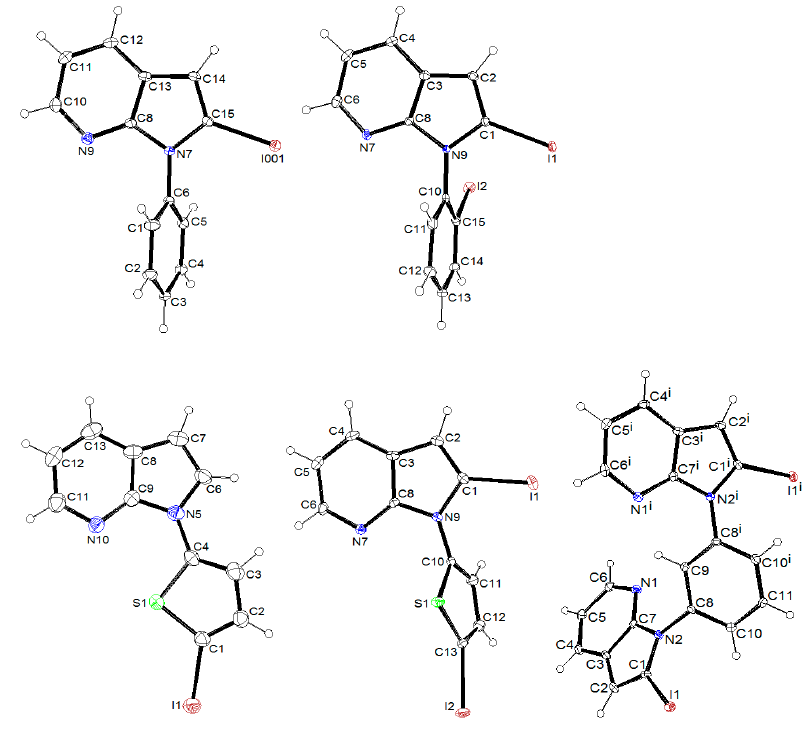
Molecules 2021 , 26 , x FOR PEER REVIEW Figure 7. ORTEP diagrams (30% probability) of 3a , 3a ′ , 3g , 3g ′ and 3k ′ . Figure 7. ORTEP diagrams (30% probability) of 3a , 3a (cid:48) , 3g , 3g (cid:48) and 3k (cid:48) .